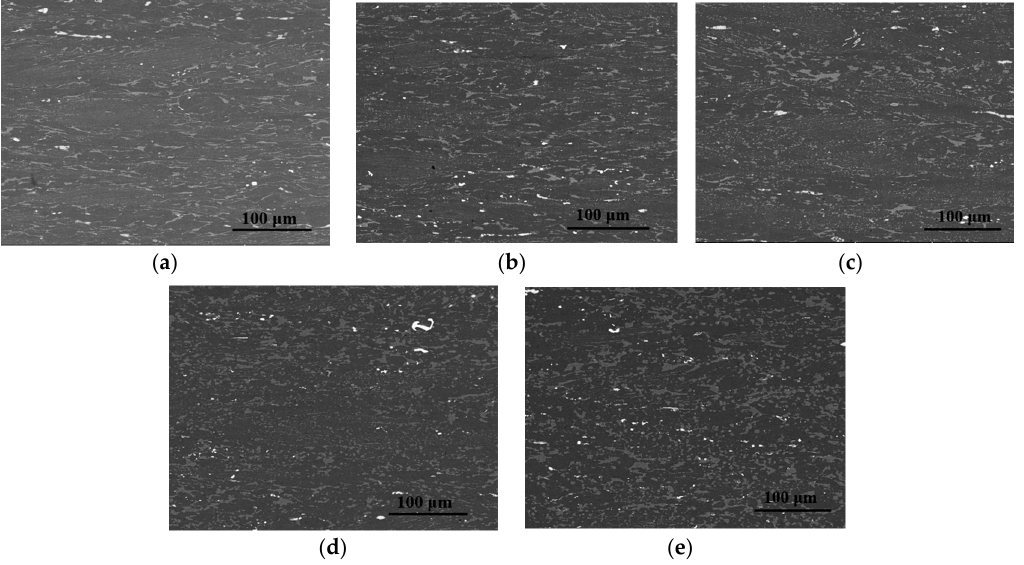
Figure 5. Microstructures of specimens isothermally deformed at the strain rate of 0.01 s − 1 and different temperatures ( a ) 1000 ◦ C; ( b ) 1050 ◦ C; ( c ) 1100 ◦ C; ( d ) 1150 ◦ C; ( e ) 1200 ◦ C.